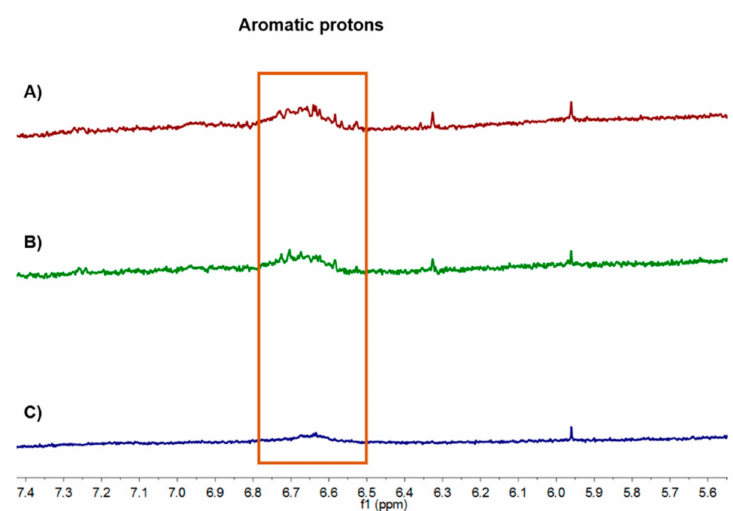
Figure 3. The 1 H NMR spectra of the bamboo extracted liquid: ( A ) original extracted liquid; ( B ) control reaction without laccase and ( C ) solution after polymerization with laccase (100 U/mL; 40 ◦ C; in a water